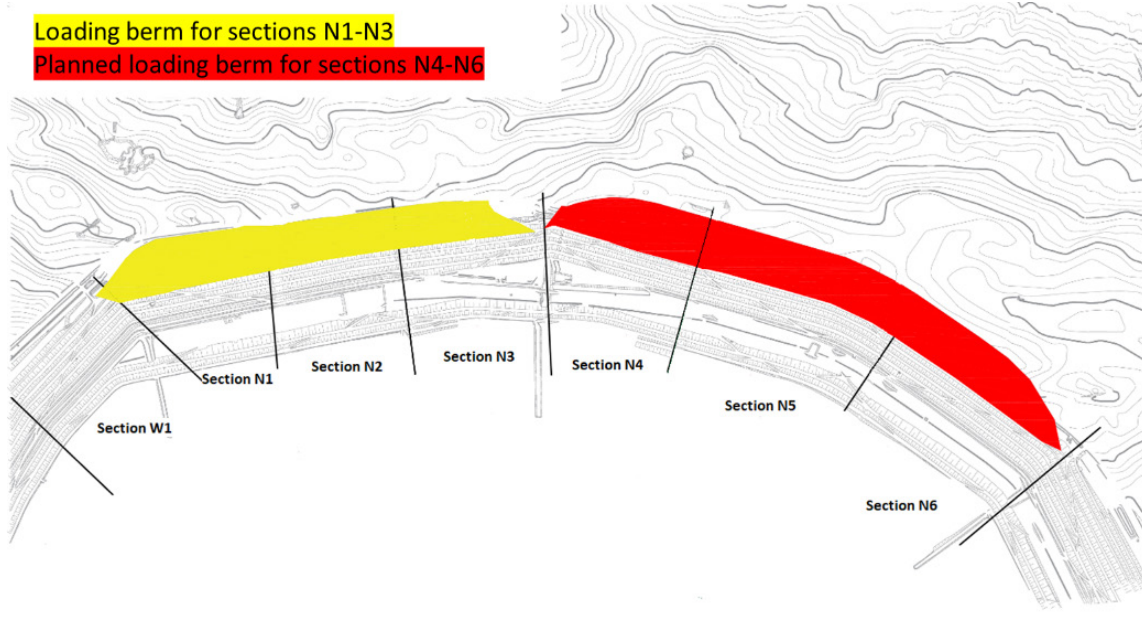
Figure 2: Loading berms on the northern